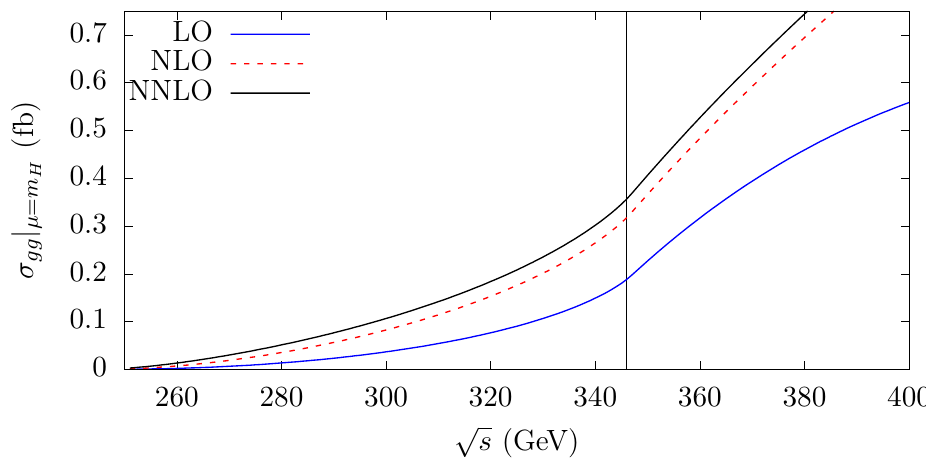
Figure 14 . gg contribution to the total partonic cross section at LO, NLO and NNLO as a function √ of s